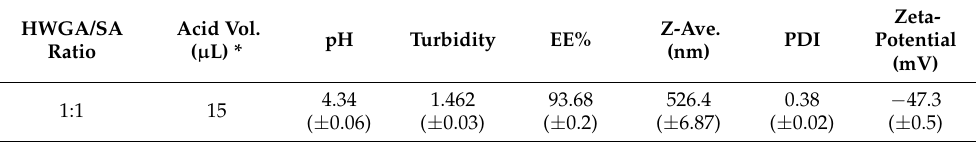
Table 2. Characteristics of a representative complex coacervate encapsulating bFGF.